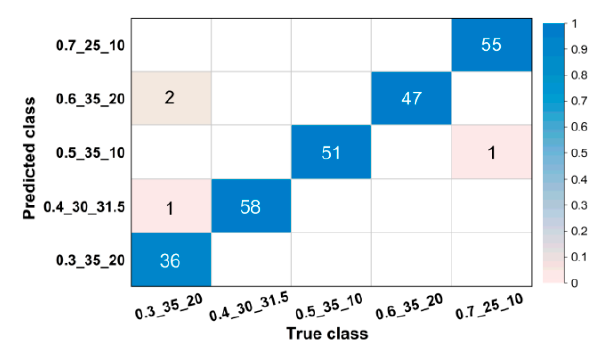
Figure 4. Confusion matrix for validation set of Net- Ⅰ.